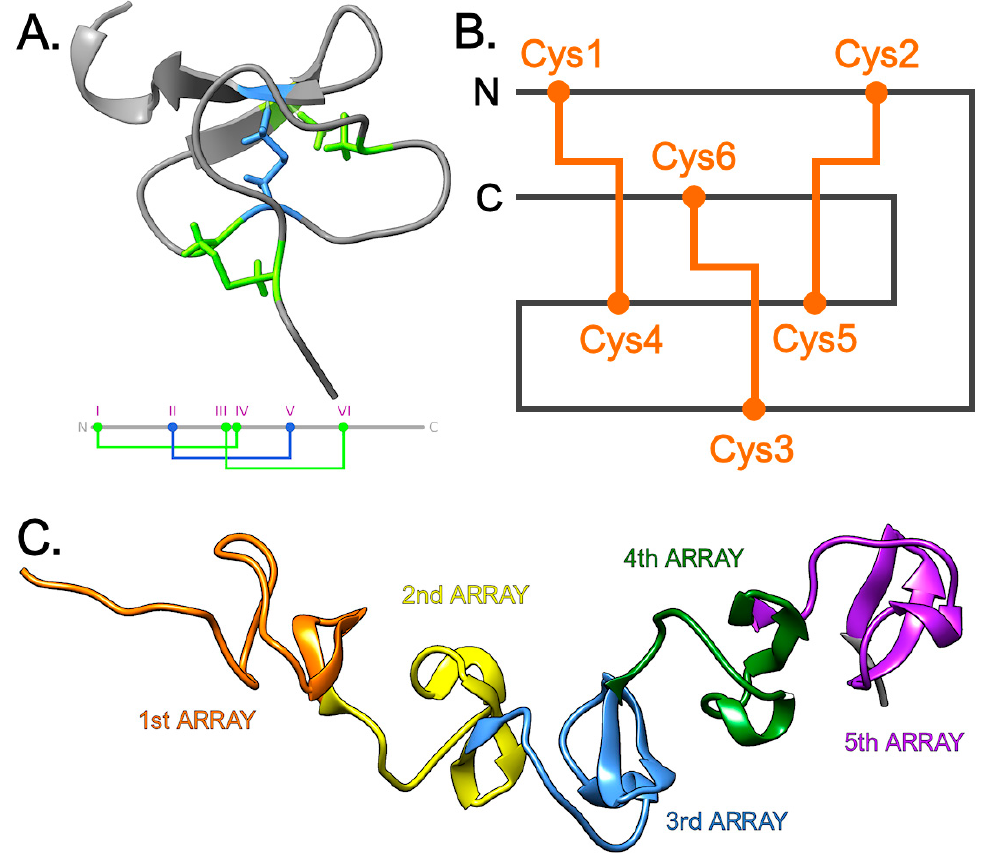
Figure 8. Panel ( A ): predicted 3D structure of sCRP-I A3, with a simplified view of the inferred disulfide connectivity, plotted on the linearized sequence of the peptide. Panel ( B ): exemplified typical disulfide array of the knottin superfamily, predicted to be present also in the CRP-I family. Panel ( C ): “pearl necklace” structural organization of a mCRP-I mature peptide, here exemplified by mCRP-I ν 1.